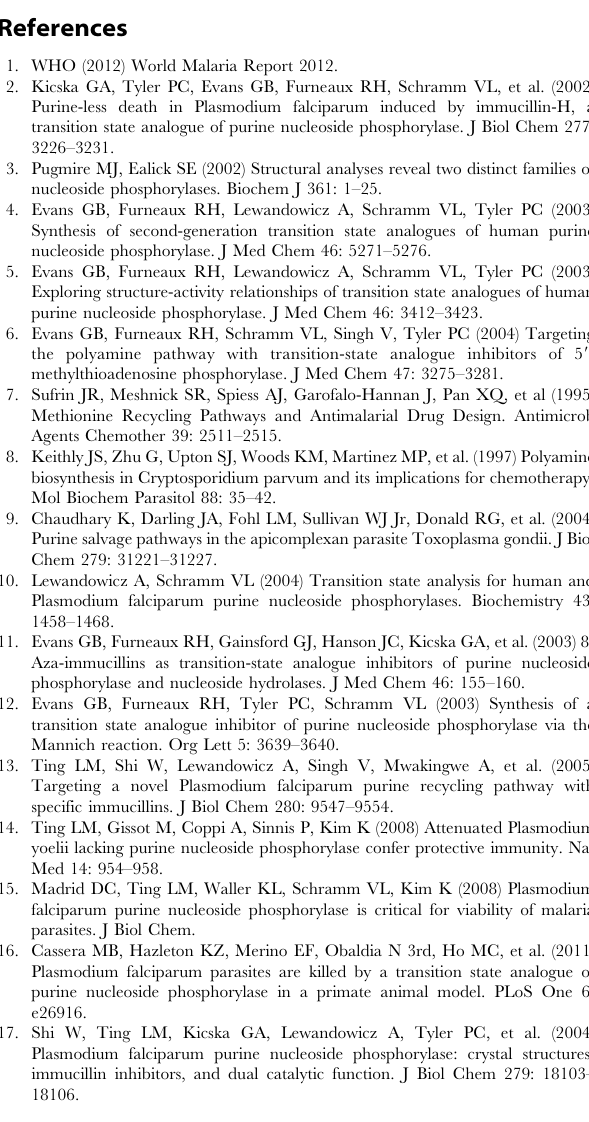
Figure S2 Omit Fo-Fc map for V66I:V73I:Y160F PfPNP mutant with ImmH. Omit Fo-Fc map (red) contoured at 3 s . The resolution for this map is 2.8 A˚ . Figures were prepared with MacPyMol [23]. Table S1 Primers used for site-directed mutagenesis construc- tion of PfPNP. Table S2 Data processing and refinement statistics for V66I:V73I:Y160F PfPNP crystal